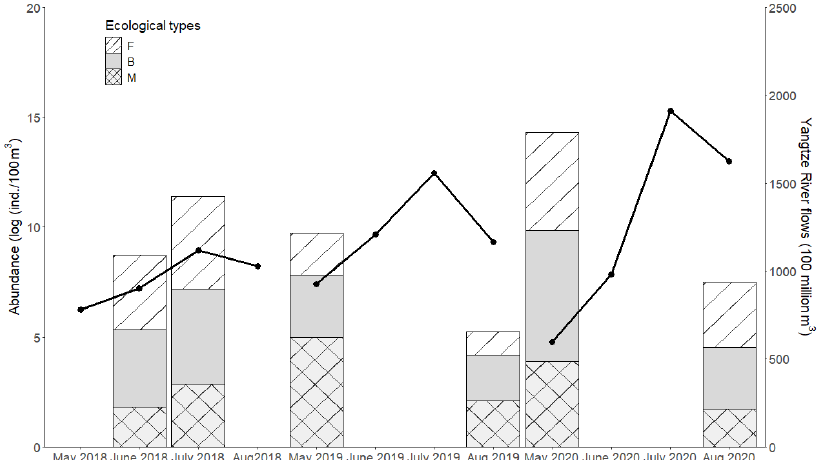
Figure 5. Mean abundance (log (ind./100 m 3 )) of larval fish of different ecological guilds and the Yangtze River flows (100 million m 3 ) from May to August during 2018, 2019, and 2020 (bar plot for abundance of larval fish; line plot for Yangtze River flows).